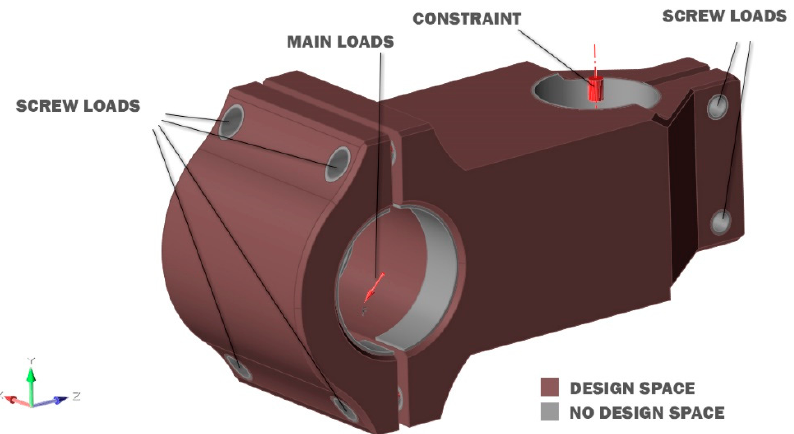
Figure 5. Definition of loads and constraints, as well as design and non-design spaces in the Inspire™ tool for the modified stem geometry.